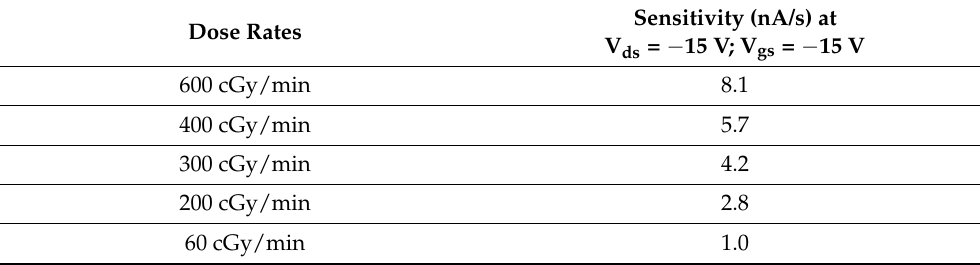
Table 1. The sensitivity of the pentacene OTFTs with PS electret during real-time readout in a wired configuration irradiated with a 6 MV photon